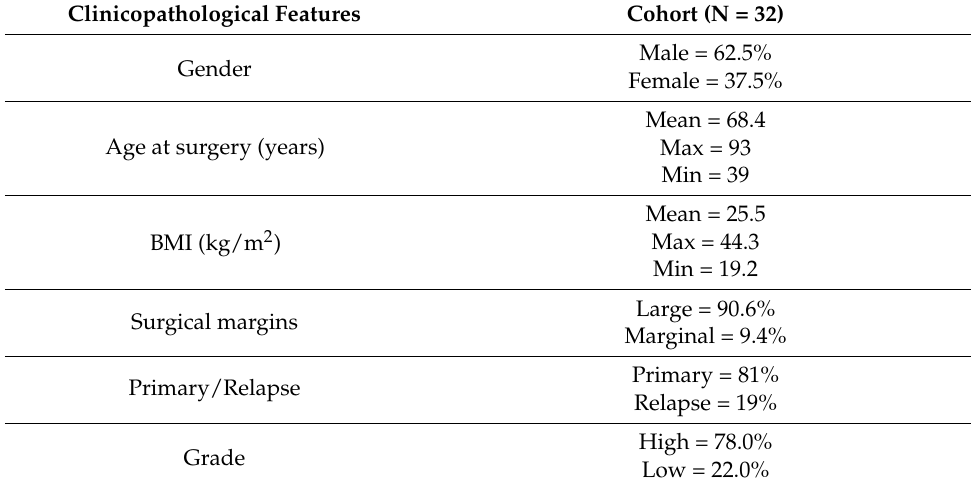
Table 1. Clinicopathological features of the patients enrolled with STS.